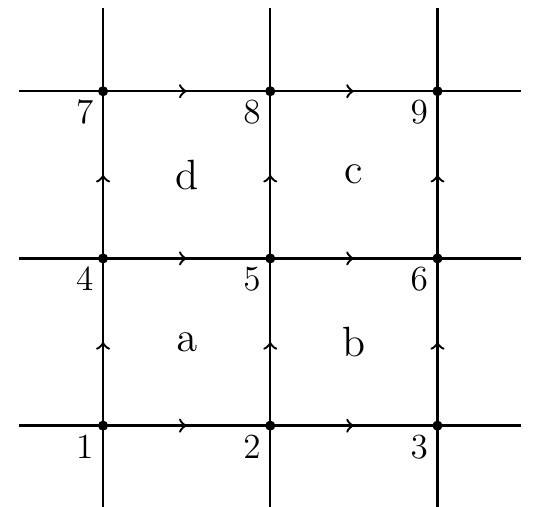
FIG. 2. Bosonization on a square lattice [2]. We put Pauli matrices X e , Y e , Z e on each edge and one complex fermion at each face. In this figure, faces are labeled a–d and c f , c † f vertices are labeled 1–9. Each edge contains a qubit. We work on the Majorana basis γ f ≡ c f + c †